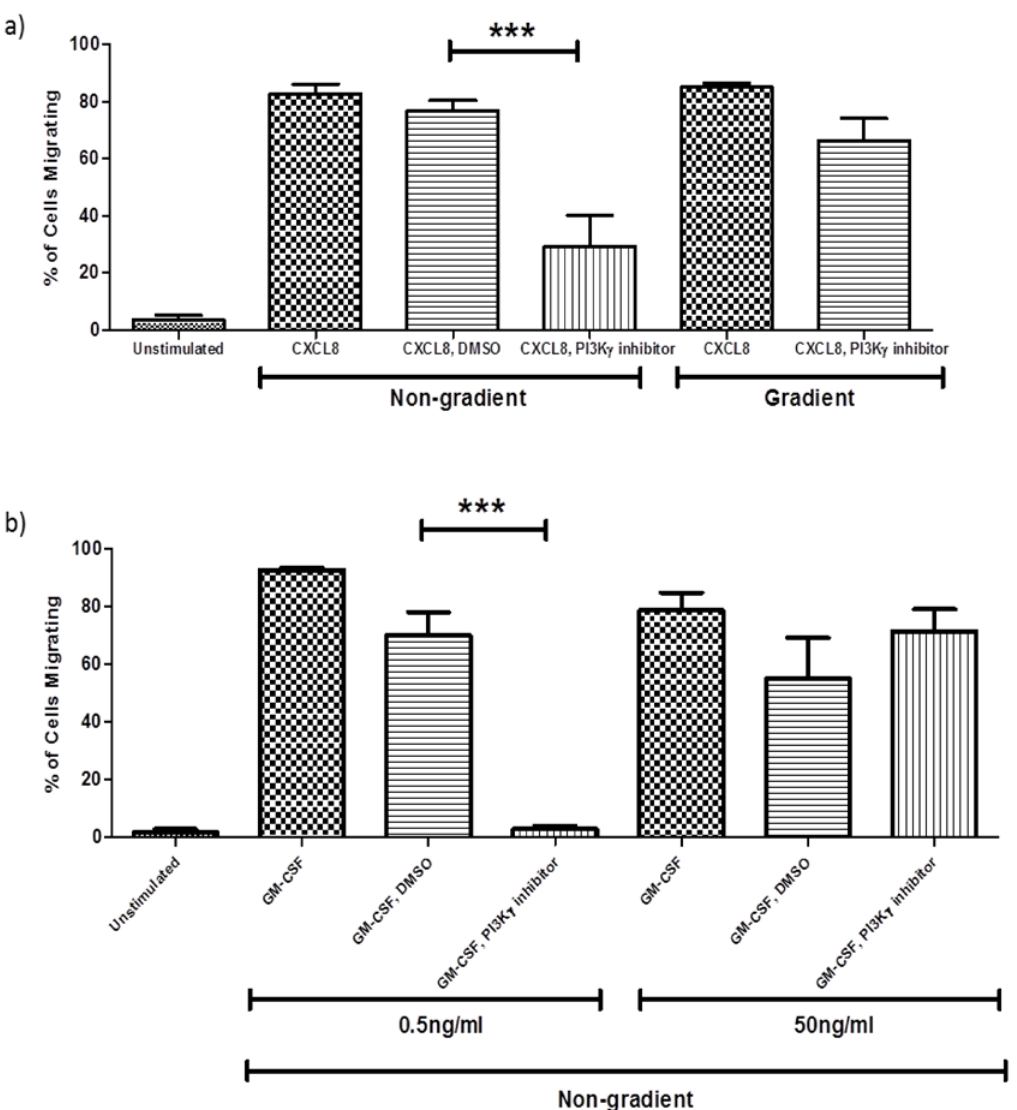
Fig 4. An antagonist of PI3K γ inhibits CXCL8 mediated chemokinetic but not chemotactic migration and GM-CSF mediated chemokinetic migration at a sub-optimal concentration of GM-CSF. Neutrophils were treated with 10 μ M PI3K γ selective inhibitor for 30 mins prior to the addition of CXCL8 (100ng/ml, a) or GM-CSF (0.5ng/ml, 50ng/ml, b). Data shown are mean ± SEM (n = 3) except for non gradient CXCL8 where n = 4 and GM-CSF where n = 6 *** p <